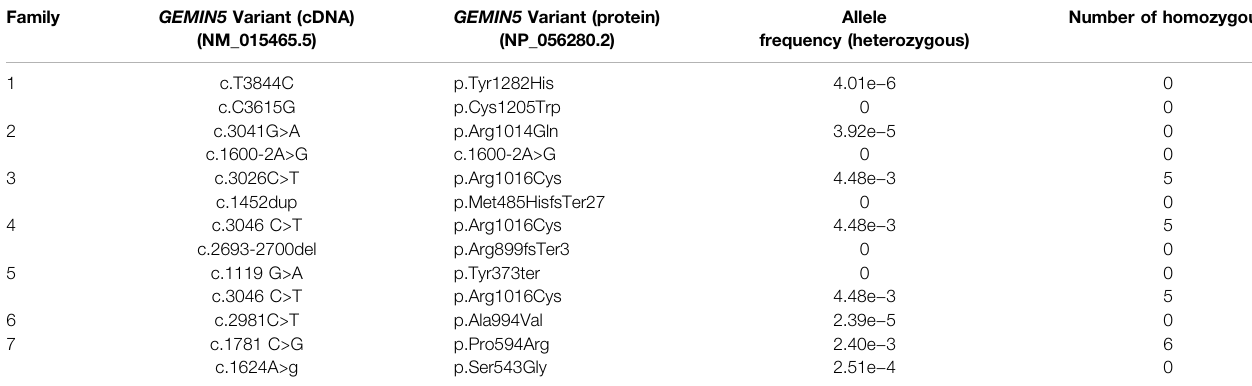
TABLE 4 | In silico prediction of GEMIN5 variants. Family GEMIN5 Variant (cDNA)